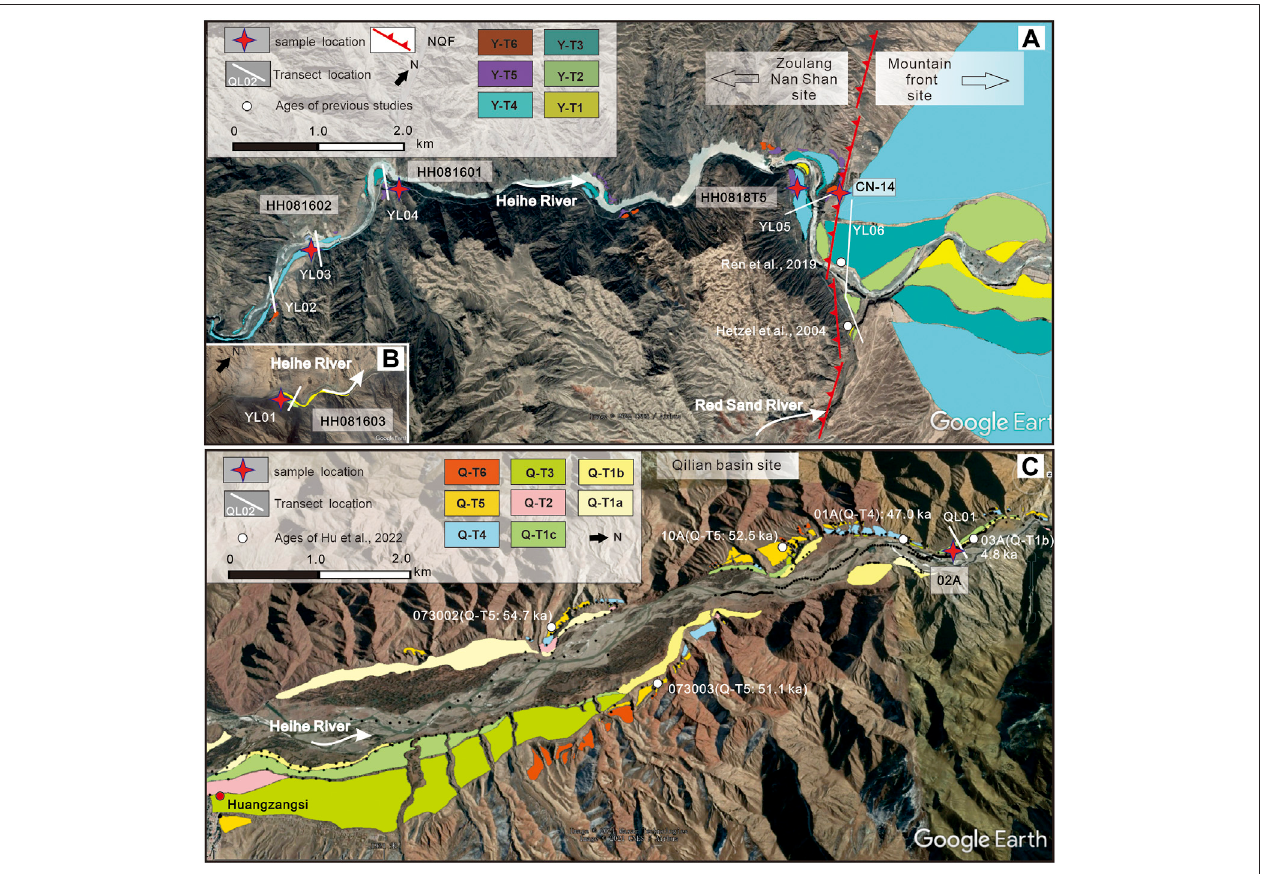
FIGURE 3 | Terrace distributions at the Zoulang Nan Shan site, mountain front site (A) and Qilian basin site (B) , with samples and transect positions. The background is from Google Earth (Map data: Image © 2019 CNES/Airbus) and the location is shown in Figure 1 .